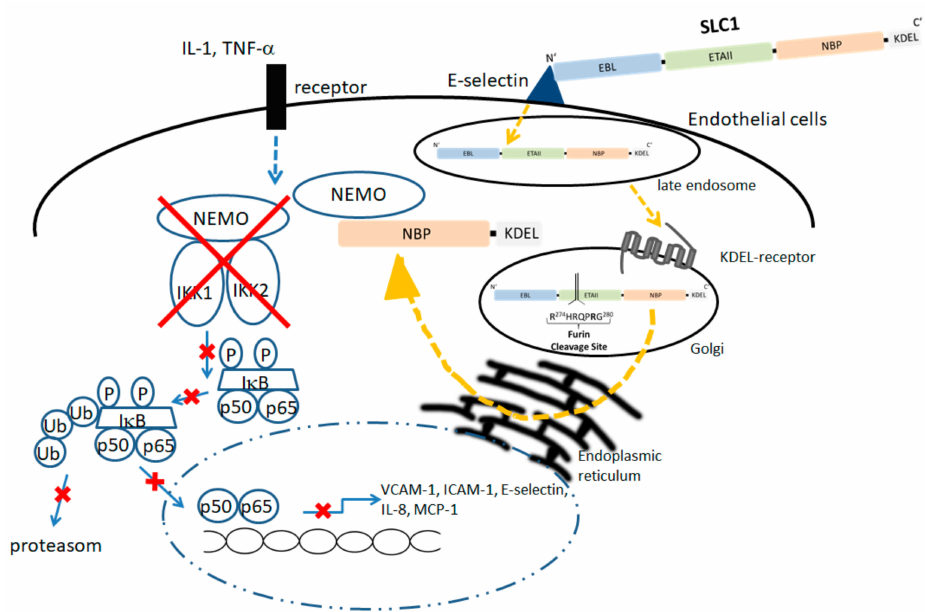
Figure 6. The SLC1 is taken up by the endothelial cell via E-selectin-mediated endocytosis and reaches upon engulfment a late endosomal compartment; via the KDEL-receptor bearing Golgi, SLC1 is passed through the ER in a retrograde fashion. In the ER, the ETAII is cleaved by furin and the C-terminal NBP element is released into the cytoplasm. Subsequently the recombinant NBP traps NEMO and leads to inhibition of IKK complex assembly (right panel). As SLC1 treatment results in a blockade of IKK assembly, subsequent steps of cytokine-induced NF-kappaB activation and finally translocation of p50 / p65 dimers into the nucleus are blocked in the endothelial cells (blocked steps are marked with red